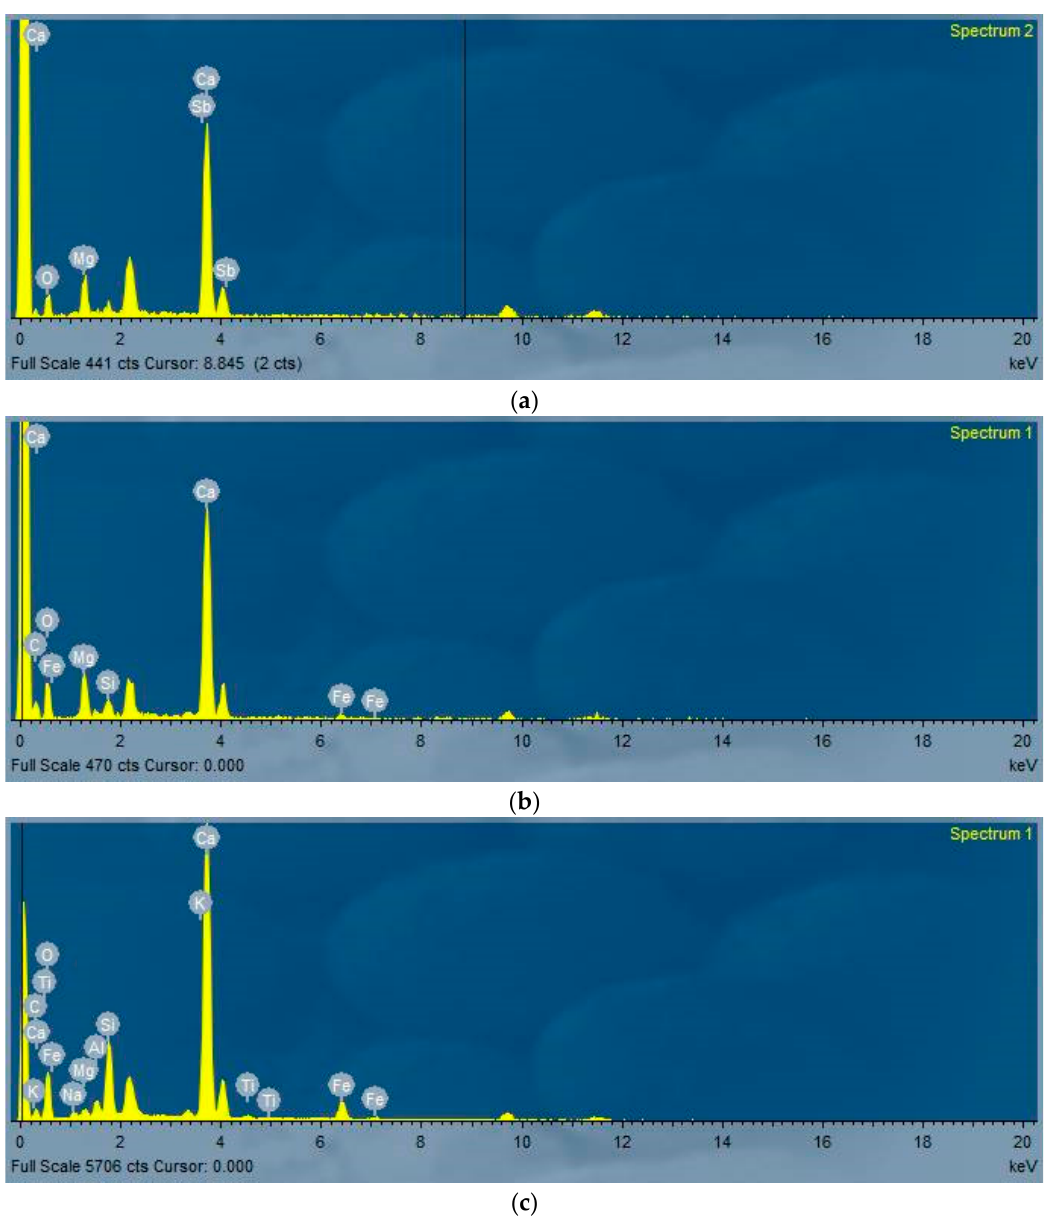
Figure 11. EDX analysis of mixes 1, 2, and 6. ( a ) Mix 1 (TW, no SF); ( b ) Mix 2 (TW, SF); ( c ) Mix 6 (MW, SF). Table 7. EDX analysis results.